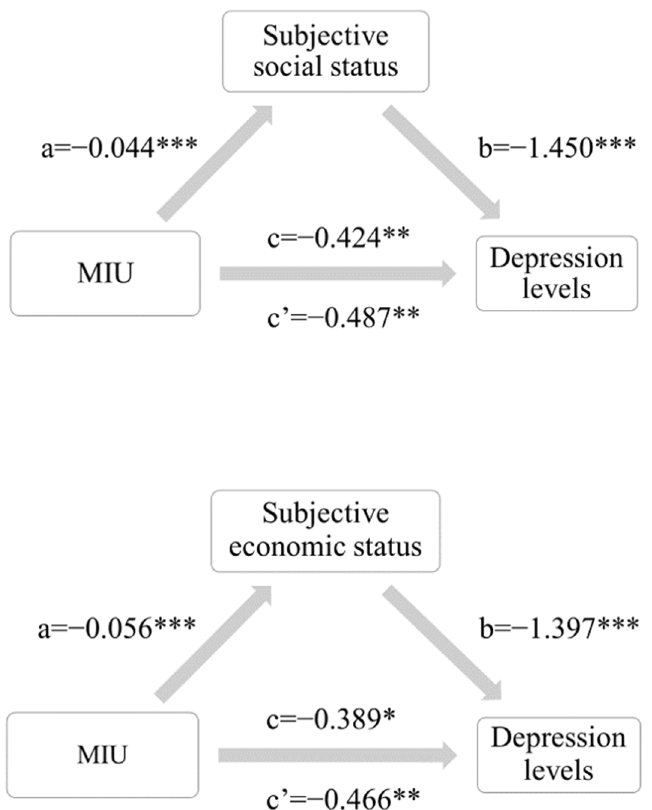
Figure 3. The influence of subjective social status and subjective ecnomic status on depression levels. * p < 0.05, ** p < 0.01, *** p < 0.001.